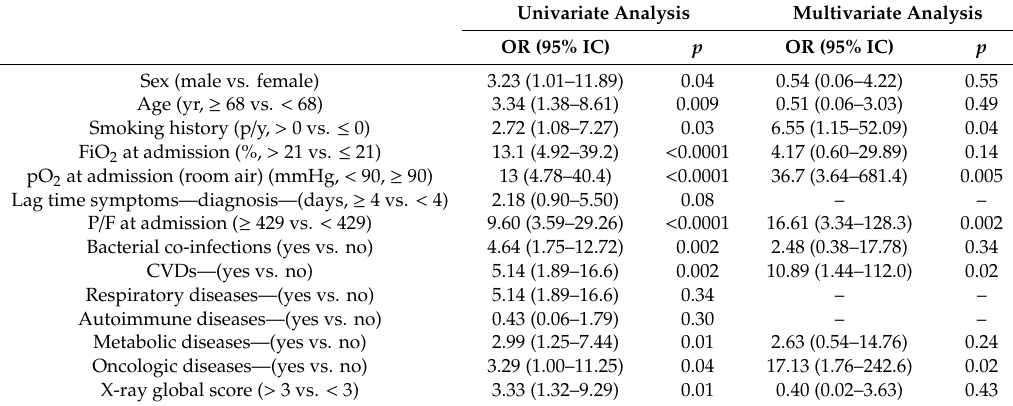
Table 3. Predictive factors of higher level of care in the overall population of patients hospitalized for COVID related infection.